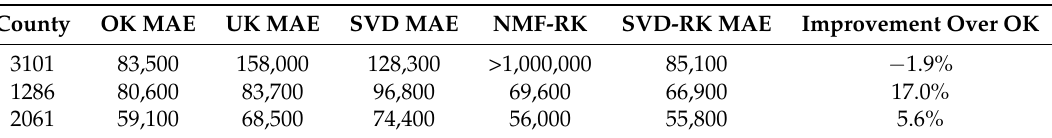
Table 3. Segmenting SVD Matrices and Kriging.